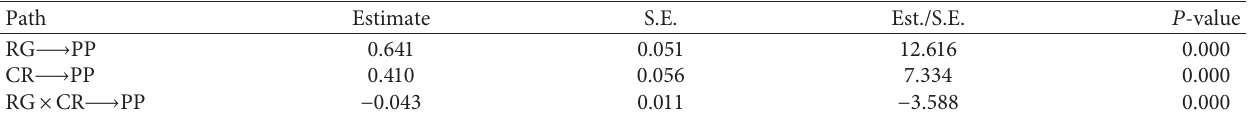
Table 5: Standardized path coefficient.